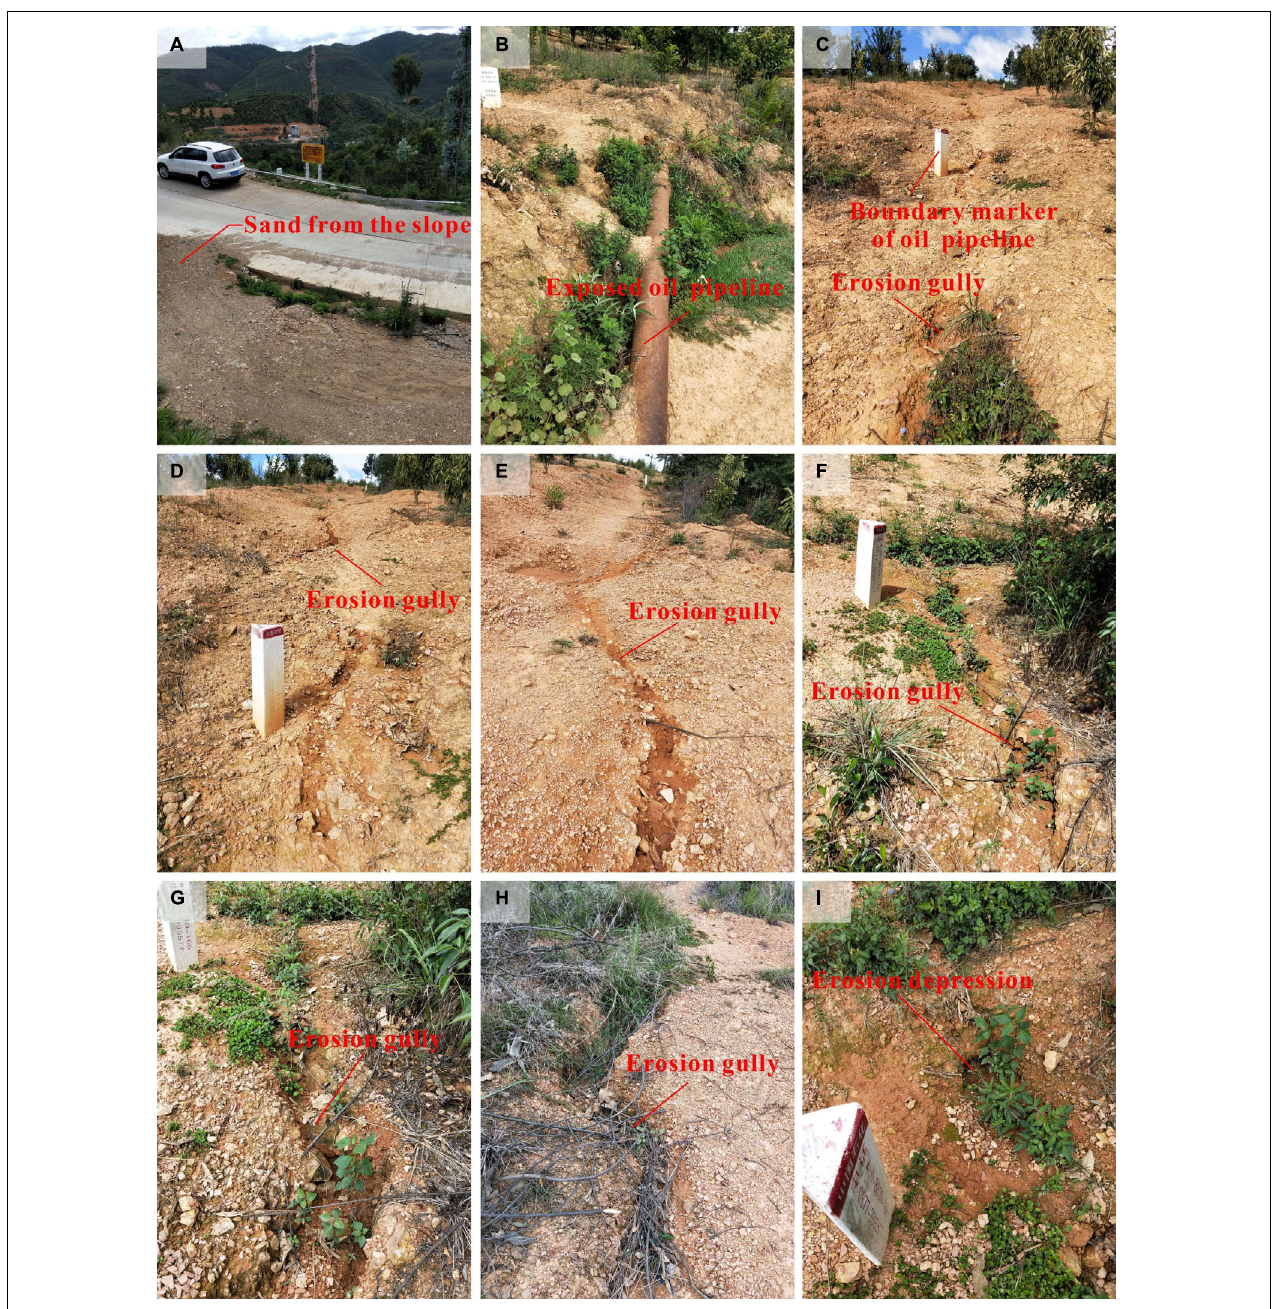
FIGURE 16 | Soil erosion near the oil pipeline. (A) The slope material was washed up on the road by the rain, (B) Exposed oil pipeline, and (C–I) Erosion gullies formed by rainfall.